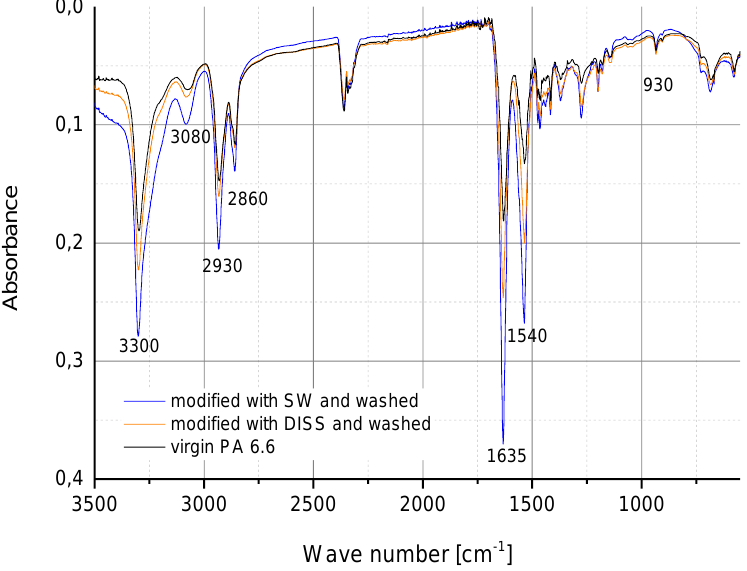
Figure 8. FTIR spectra of virgin PA 6.6 fibre and modified fibres using SW and DISS respectively after washing.